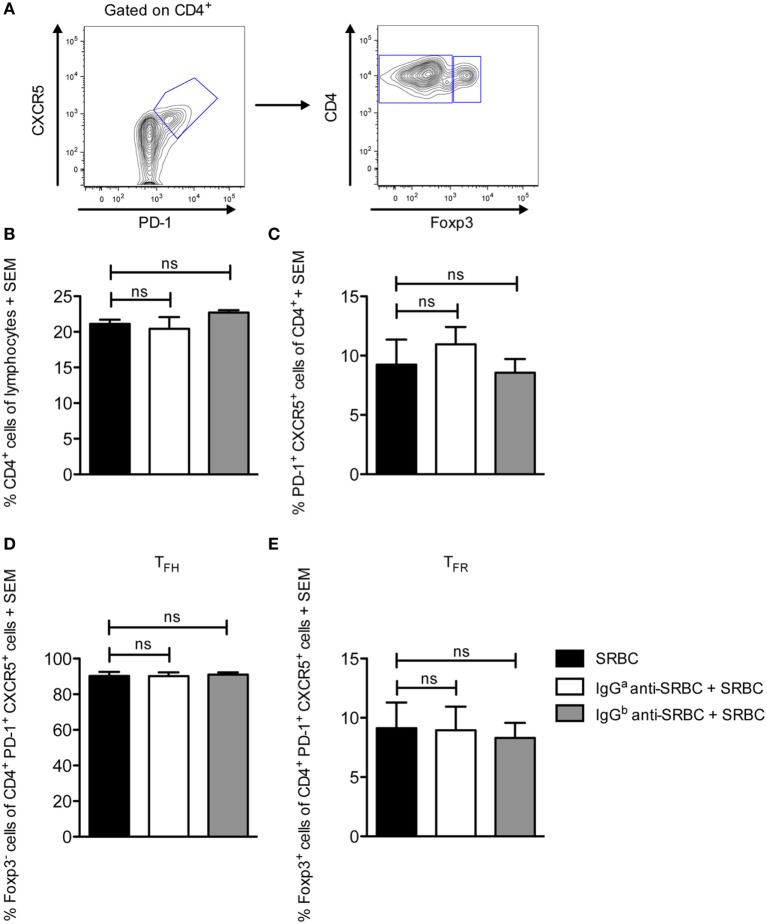
IgG does not change the proportions of the TFH and TFR populations. Splenocytes from the same spleens as in Figure 2 were used. On day 10 after immunization, spleens were harvested for analysis of TFH and TFR CD4+ cell populations by flow cytometry. (A) Representative contour plot showing the gating strategy. (B–E) Quantification of flow cytometry data for groups immunized with 10 µg syngeneic IgGa + 5 × 106 sheep red blood cells (SRBC) (white bars), 10 µg allogeneic IgGb + 5 × 106 SRBC (gray bars), and 5 × 106 SRBC alone (black bars) (n = 3/group). Data represent (B) % CD4+ cells of lymphocytes, (C) % CXCR5+PD-1+, (D) % CXCR5+PD-1+Foxp3− TFH, and (E) % CXCR5+PD-1+Foxp3+ TFR of CD4+ lymphocytes. Data are representative of two independent experiments/IgG allotype (ns, p > 0.05; *p < 0.05; **p < 0.01; ***p < 0.001).